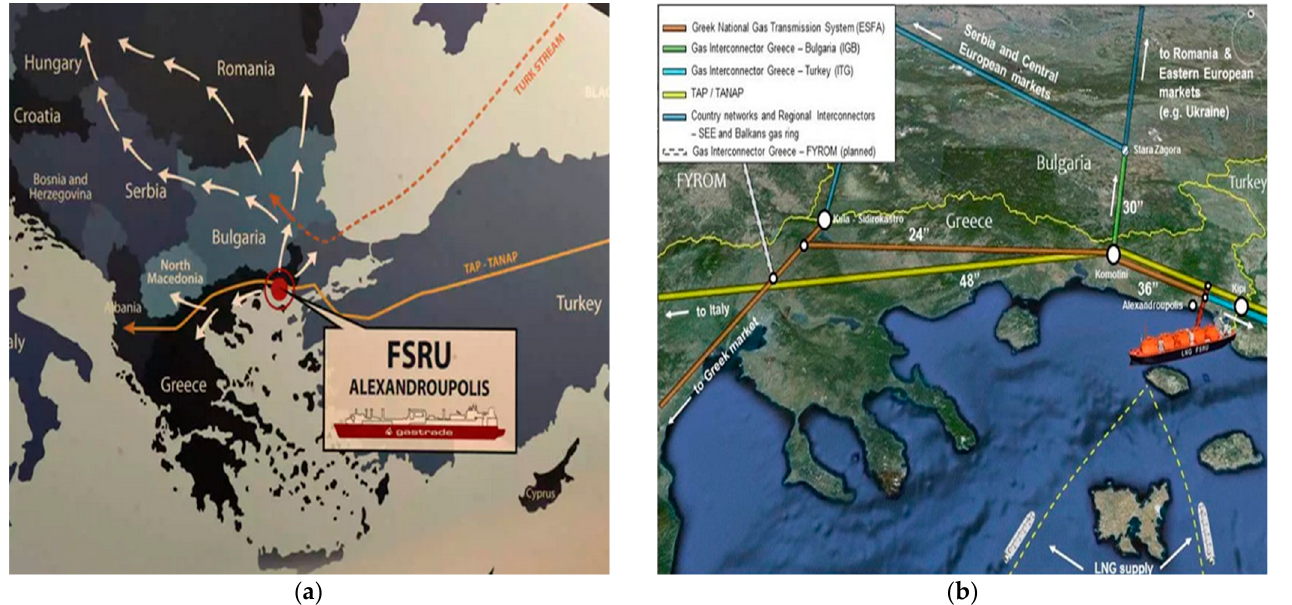
Figure 1. ( a ) Alexandroupolis FSRU interconnections [25]; ( b ) Alexandroupolis FSRU location [25].